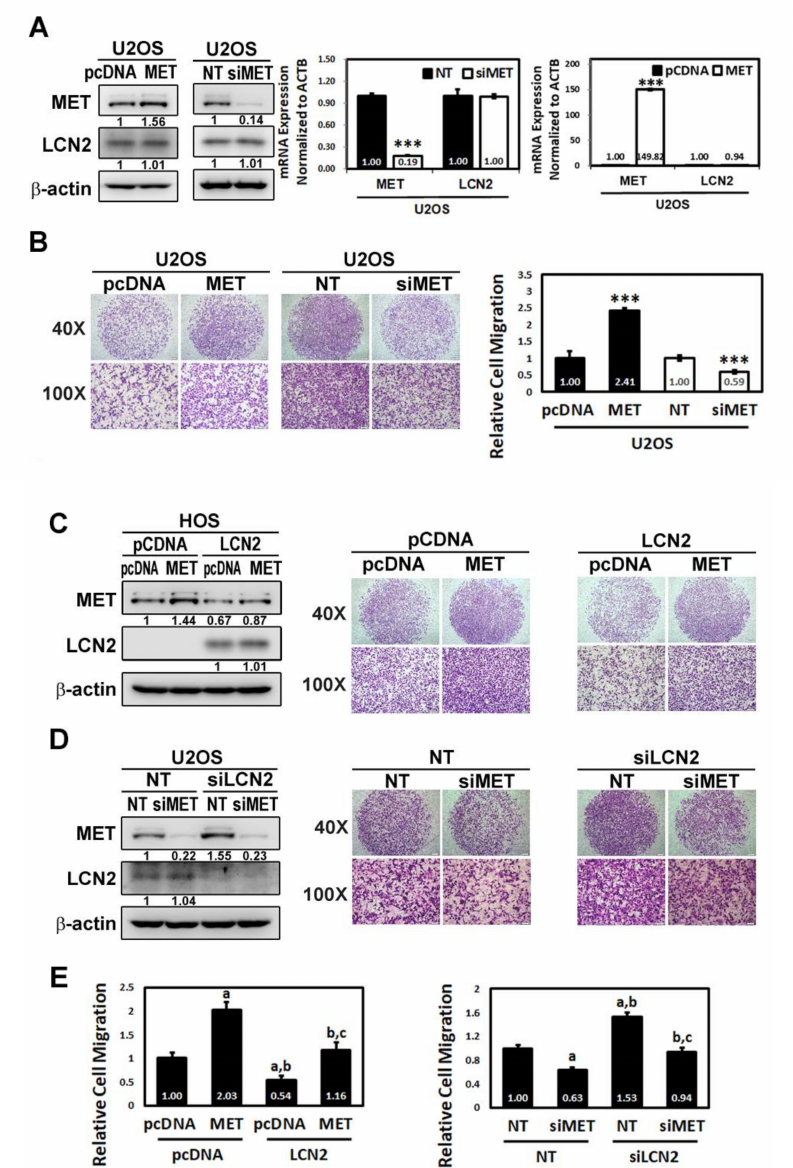
Figure 4. Effects of MET on U2OS and HOS cells migration. ( A ) Western blot analyses for MET and LCN2 proteins in U2OS cells after transfection with vectors containing a constitutively active MET cDNA and siRNA directly against the MET expression were measured. RT–PCR for MET and LCN2 mRNA expressions in U2OS cells after siRNA directly against the MET expression and U2OS cells after transfection with vectors containing a constitutively active MET cDNA were measured and subsequently subjected to quantitative analysis. *** p < 0.001 compared with the vehicle group. ( B ) Cell migration assays for U2OS cells after transfection with vectors containing a constitutively active MET cDNA and siRNA directly against the MET expression were measured and subsequently subjected to quantitative analysis. *** p < 0.001 compared with the vehicle group. ( C – E ) Western blot analyses and cell migration assays for HOS cells with or without overexpression of LCN2, transfected with vectors containing a constitutively active MET cDNA, and U2OS cells with or without knockdown of LCN2, siRNA directly against the MET expression, were measured, respectively, and migratory cells were subsequently subjected to quantitative analysis. HOS: F: 82.987, p < 0.001; U2OS: F: 150.955, p < 0.001. a Significantly different, p < 0.05, when compared with HOS cells without overexpression of LCN2 and MET, or U2OS cells without silencing of LCN2 and MET. b Significantly different, p < 0.05, when compared with HOS cells without overexpression of LCN2 but with overexpression of MET, or U2OS cells without silencing of LCN2, but with MET. c Significantly different, p < 0.05, when compared with HOS cells with overexpression of LCN2 but without overexpression of MET, or U2OS cells with silencing of LCN2, but without silencing of